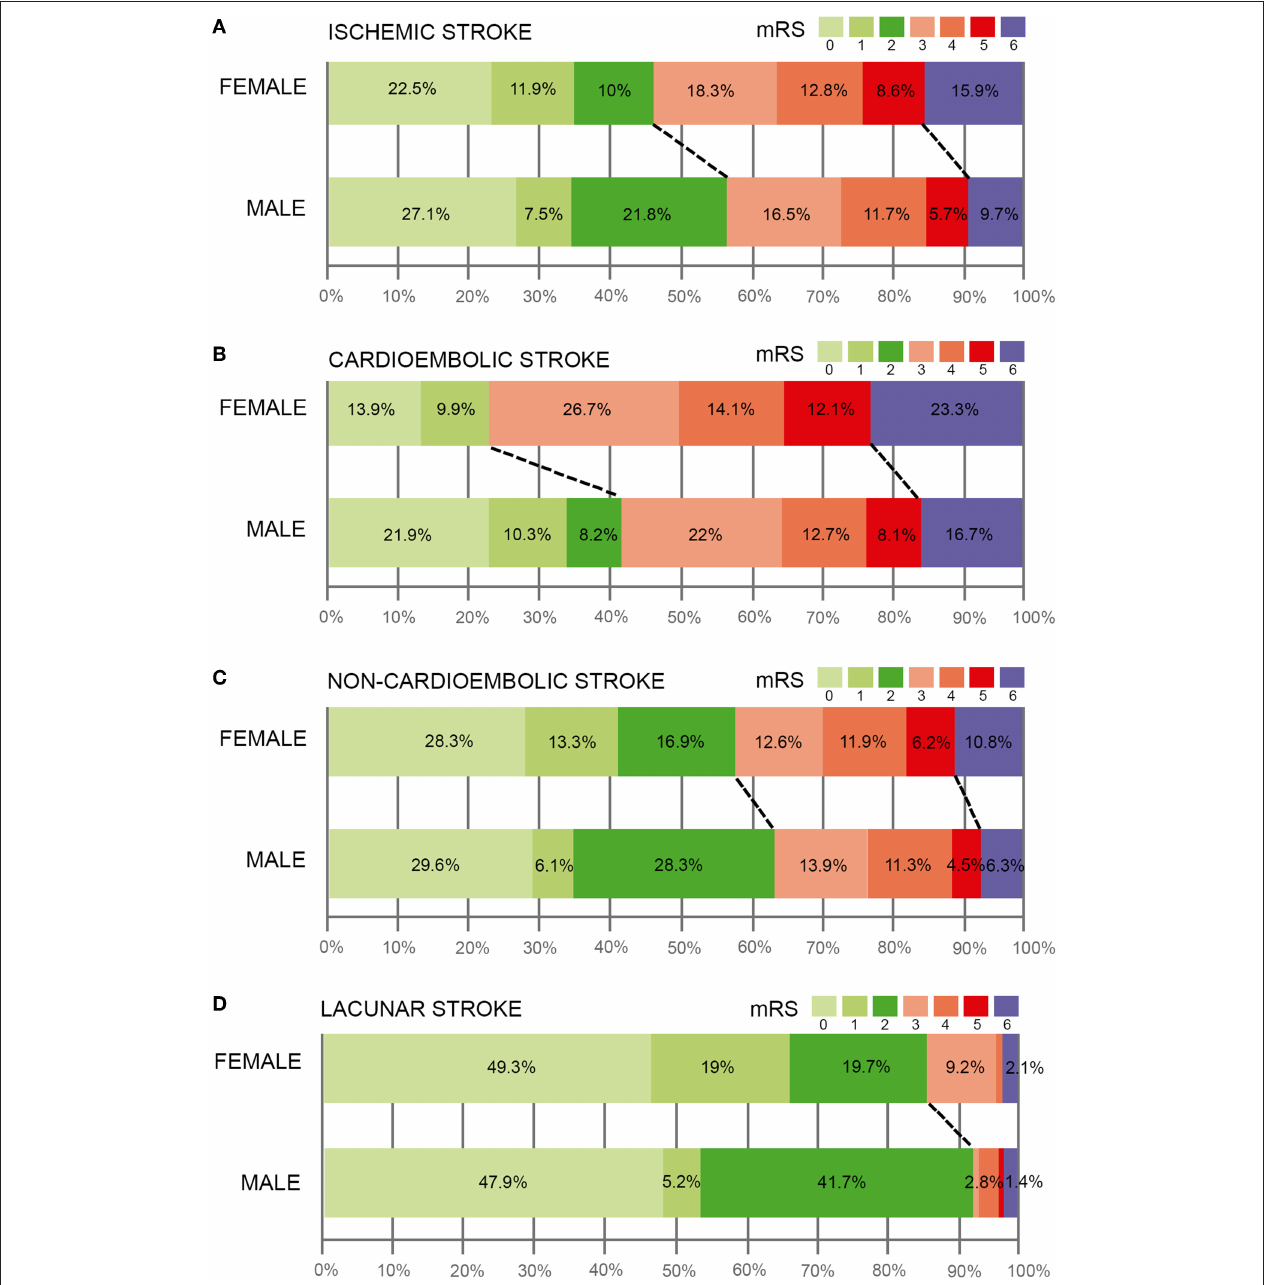
FIGURE 1 | Modified Rankin Scale (mRS) scores in ischemic stroke patients (A) , cardioembolic (B) , and non-cardioembolic (C) stroke patients categorized by sex. (D) distribution of mRS scores in lacunar